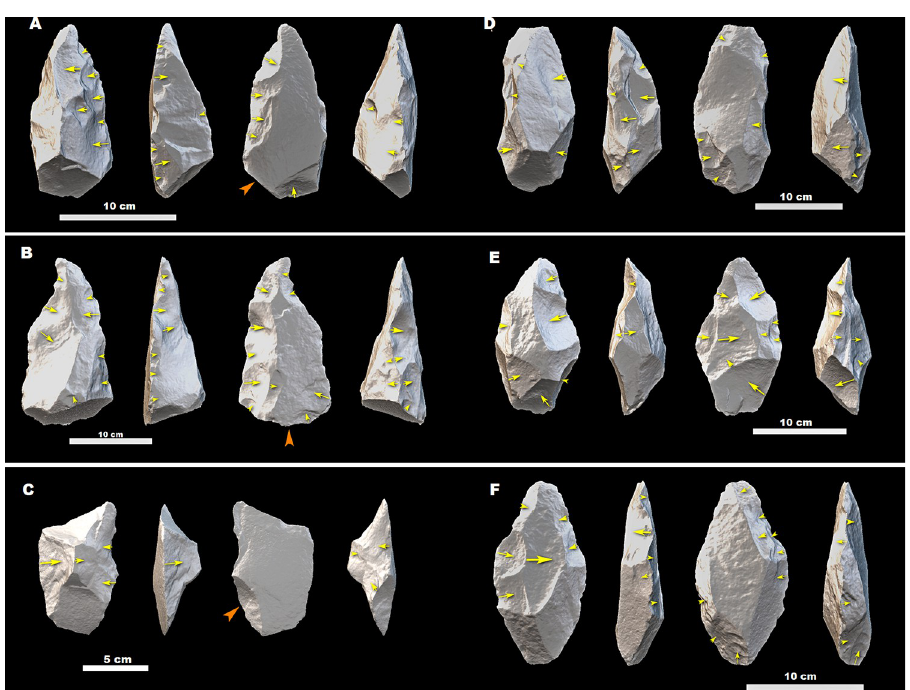
Fig 9. Trihedral picks (A and B), Cleaver (C), and Handaxes (D–F) from MW2-L1&L2. The picks and a cleaver are made on flakes (the arrows indicate the direction of flaking of flake blanks), whereas the blanks of the handaxes are indeterminate. All tools are made on glassy ignimbrite. Orange arrows indicate the direction of flaking of the blanks, while yellow arrows indicate the direction of removals during shaping phases.